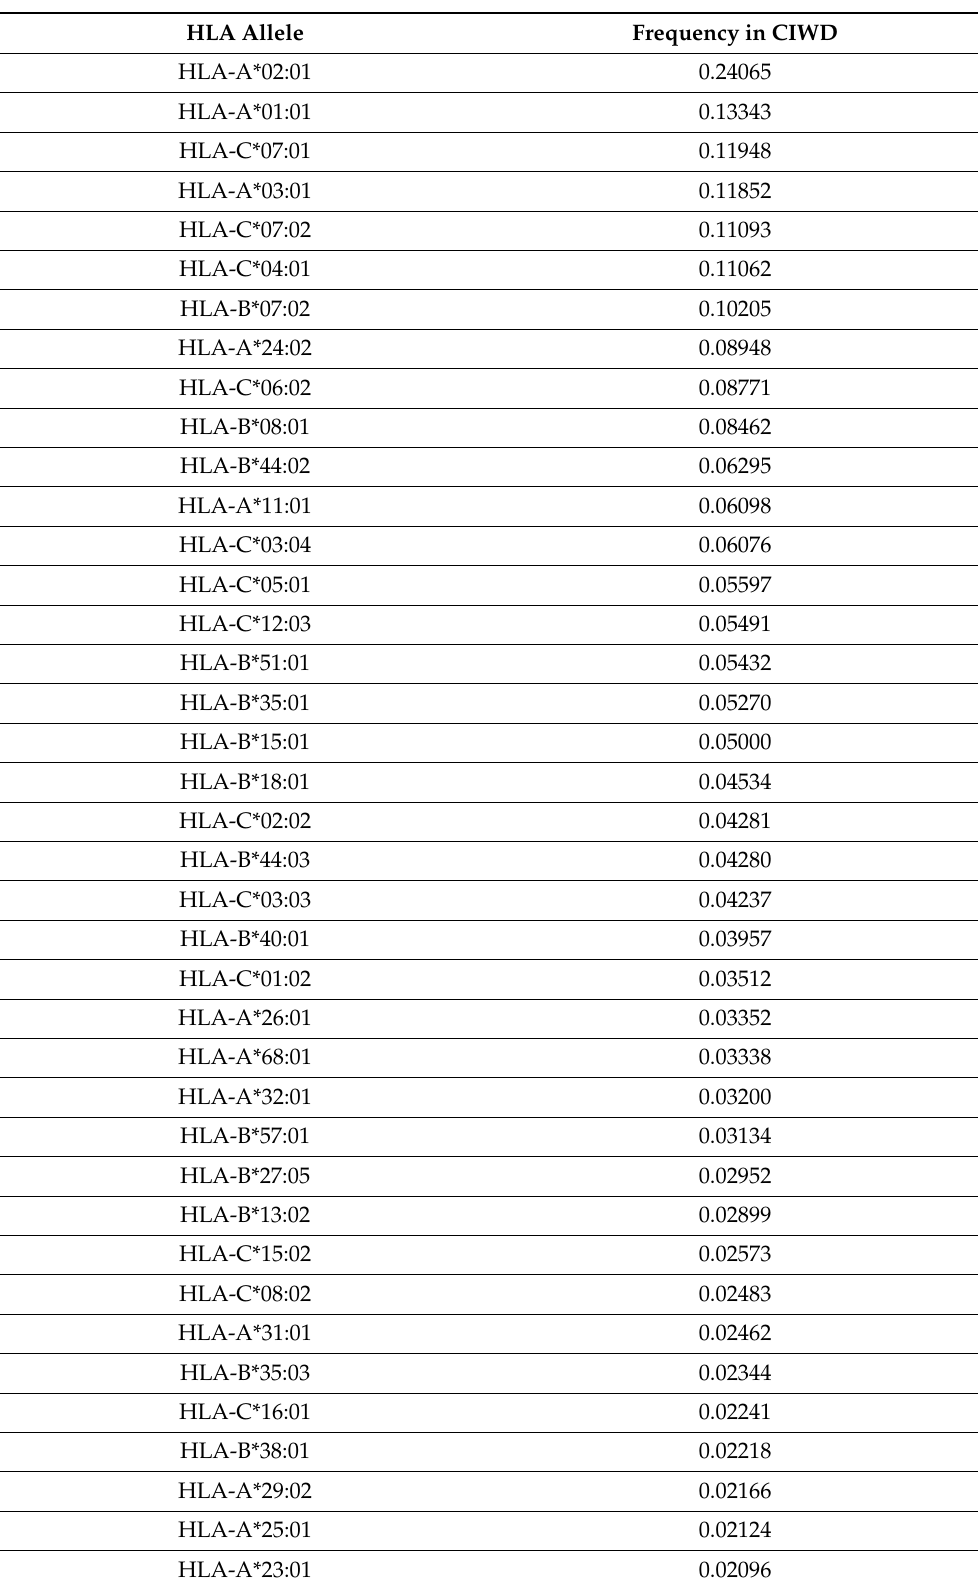
Table A2. HLA alleles of the model population and their frequency according to the Catalog of common, intermediate and well-documented HLA alleles (CIWD)